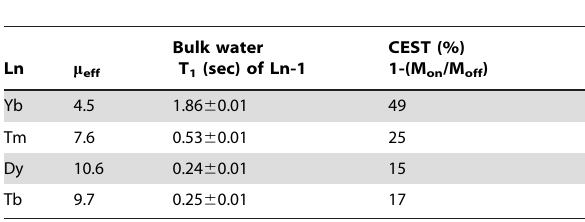
All data were collected at 9.4 T, 310 K on samples adjusted to pH 7.5.